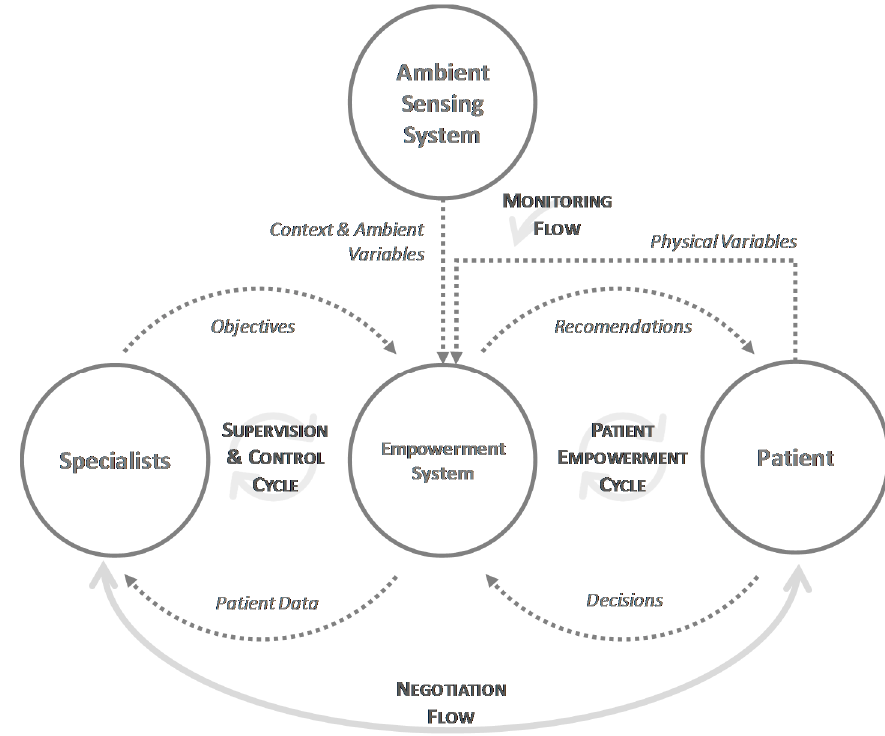
Figure 3. Management model of hypertension based on patient empowerment.